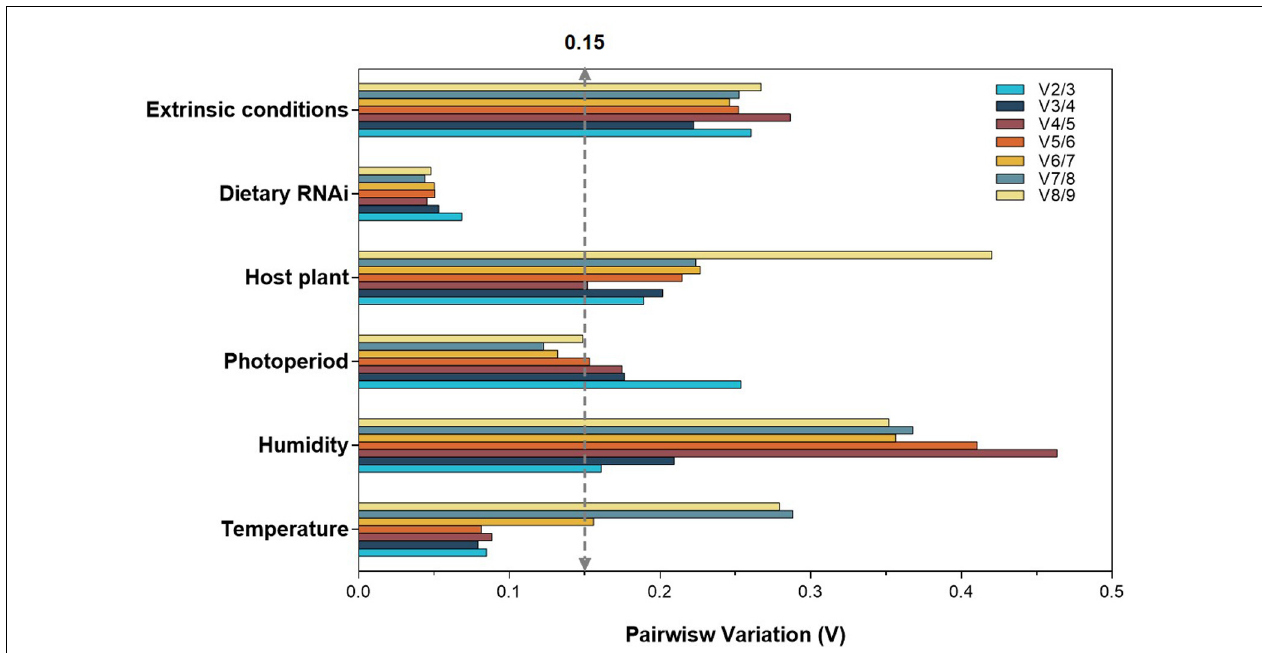
FIGURE 2 | Optimal number of reference genes for the normalization of A. viennensi under selected extrinsic experimental conditions. The pairwise variation (Vn/Vn + 1) was analyzed for the normalization factors by geNorm program to determine the optimal number of reference genes included in the RT-qPCR analysis. Values less than 0.15 indicate that another reference gene will not significantly improve